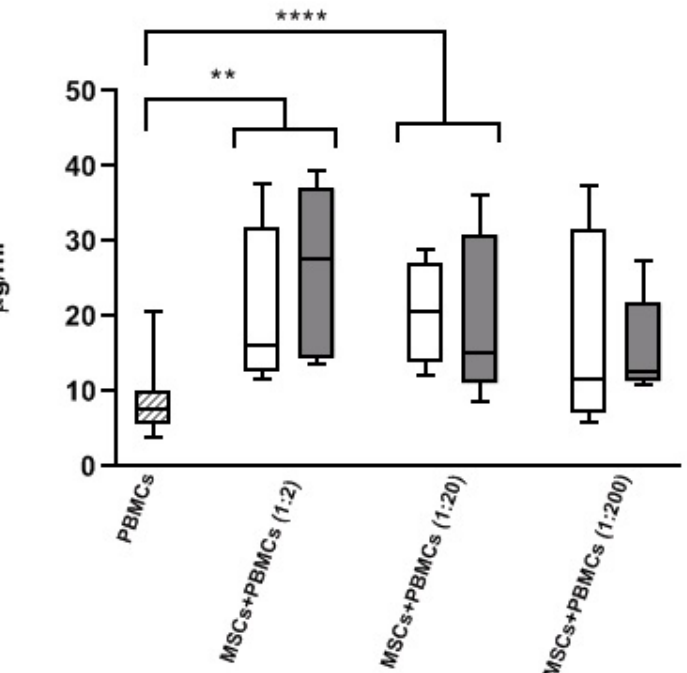
Figure 8. MSCs co-cultured with resting PBMCs. IgG secretion by PBMCs of one HD was quantified after co-culture with AL- (white bar) and HD-MSCs (grey bar) at different ratios. Results were compared to PBMCs alone (dashed bar) . Results, expressed as μ g/mL, are shown as median [25–75%, Min-Max]. ** p = 0.004, **** p < 0.0001.